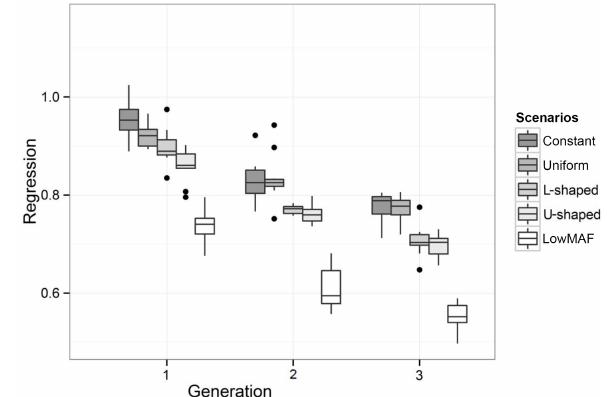
Figure 3. Regression of true breeding values on predicted breed- ing values for different distributions of the QTL allele frequency. Outliers denoted as black